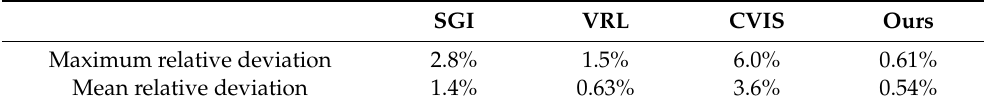
Table 2. Relative deviation comparison